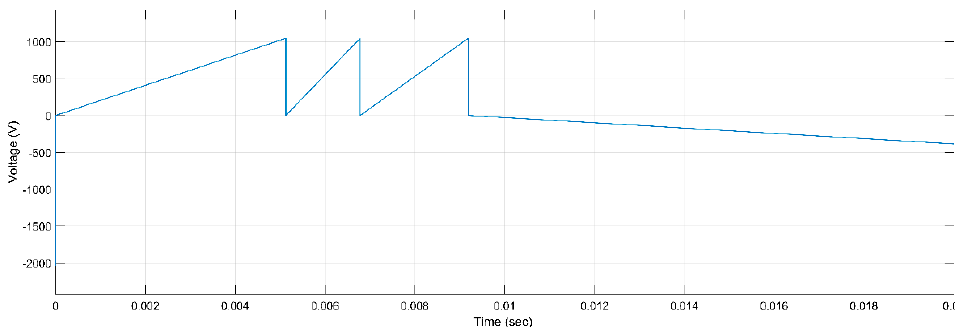
Figure 23. PD Activity for ER, 5 kV, h, r.